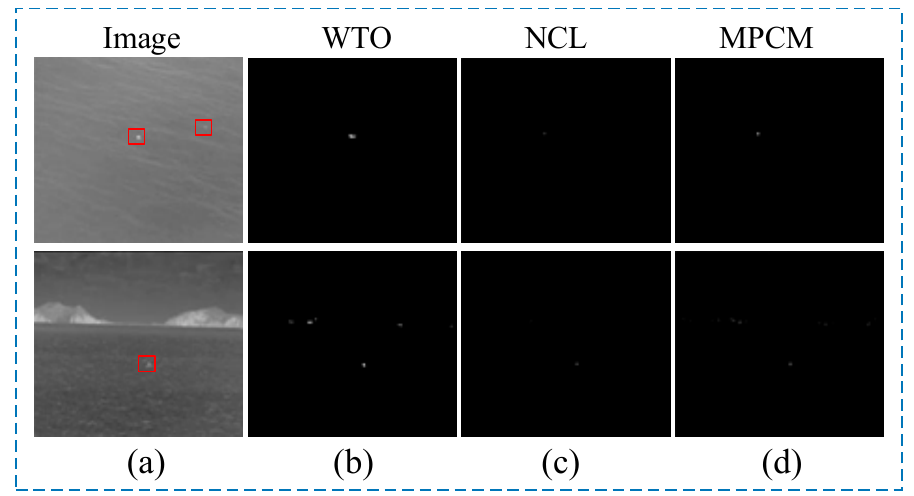
Figure 1. Results of three target detection algorithms in two typical maritime background: ( a ) denotes the original images. For the upper image in ( b – d ), they have only detected the target on the left. For the lower image in ( b – d ), they have detected the target but kept island and wave interference.